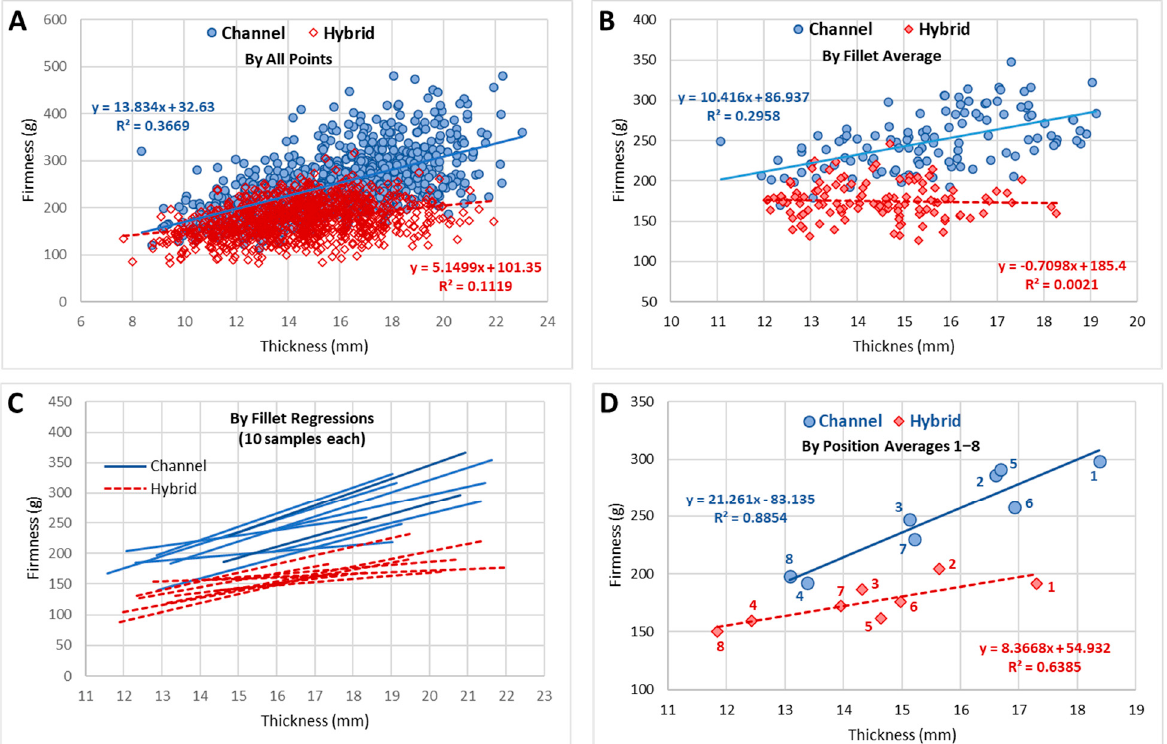
Figure 5. Data representation possibilities for attributes (thickness vs firmness). ( A ) All data points: Pearson’s correlation coefficient (r) = 0.61 for Channel, and r = 0.33 for Hybid; ( B ) Fillet averages: r = 0.54 for Channel, and no significant correlation for Hybrid; ( C ), Fillet 8-point regressions; ( D ) Position averages: r = 0.94 for Channel and r = 0.80 for Hybrid.